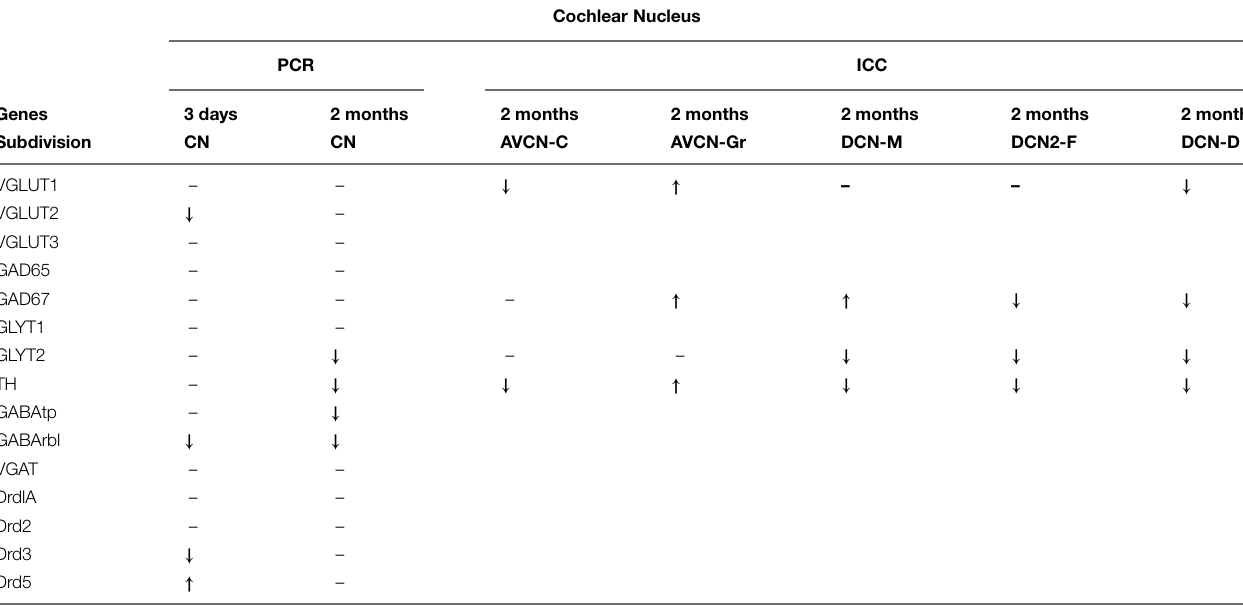
TABLE 3 | Gene expression and immunocytochemistry summary in the inferior colliculus (IC). IC PCR ICC Genes 3 days 2